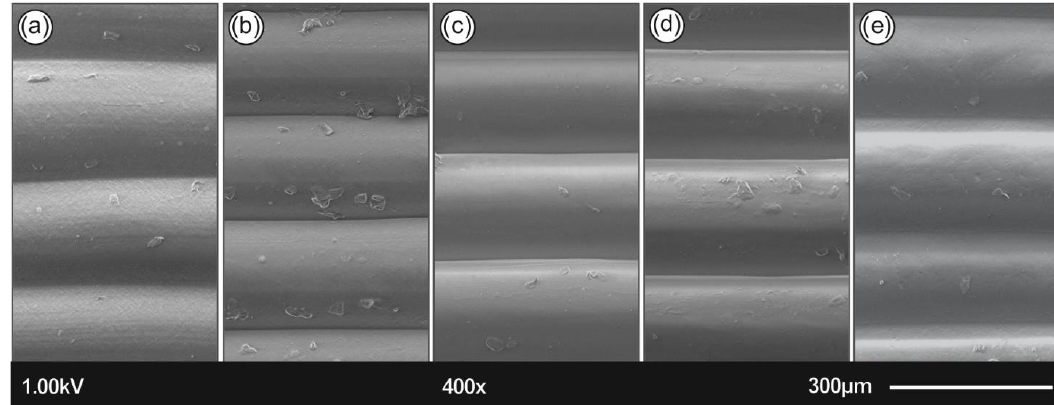
Figure 6. ( a ) Representative tensile stress (MPa)—strain (%) curve of polypropylene (PP) at a 50 mm/min elongation speed, ( b ) average tensile strength and yield strength (with the corresponding standard deviation) for PP in all five elongation speeds, ( c ) tensile modulus (with the corresponding standard deviation) of PP under the five different elongation speeds, and ( d ) strain rate sensitivity index “m”—strain (%) graph for PP.